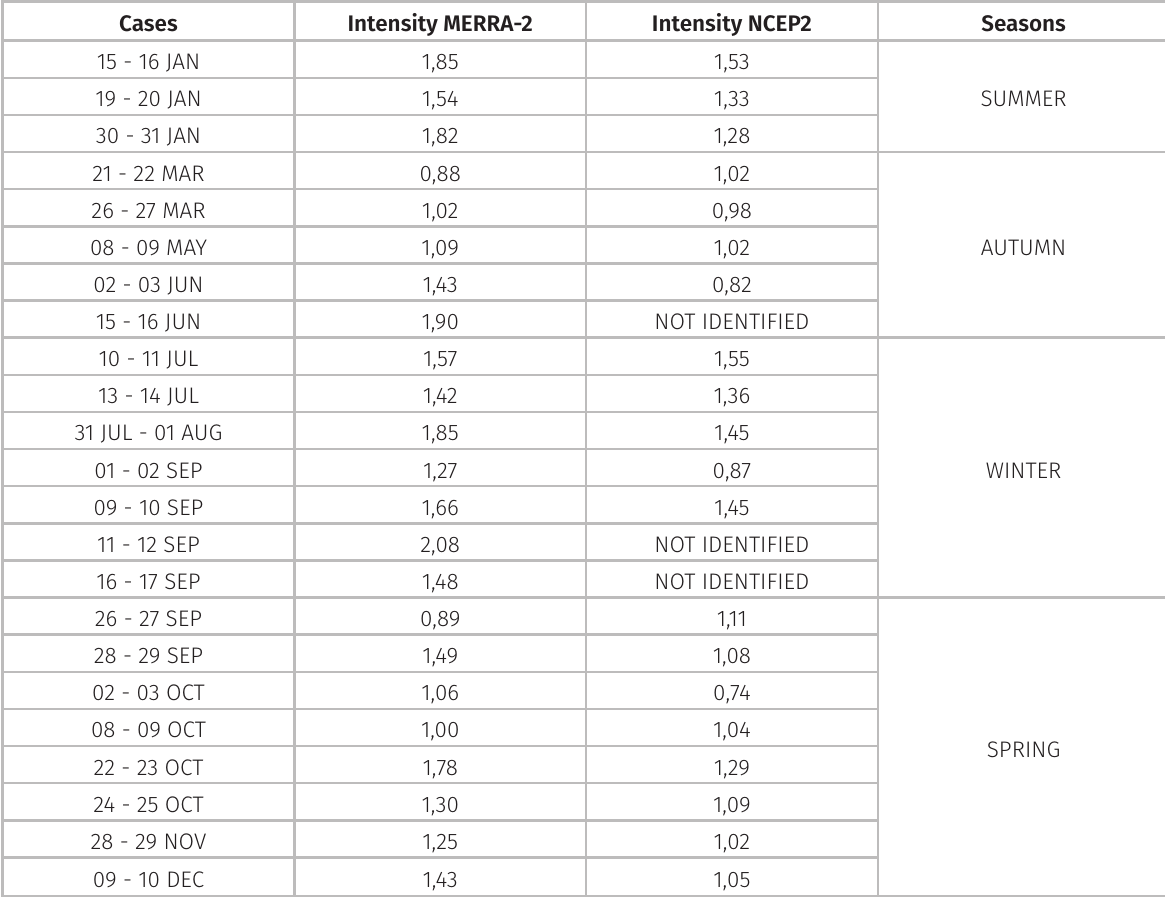
Table II. Intensity, in Bergeron, of the cases for both reanalyses and seasonal distribution in 2015.